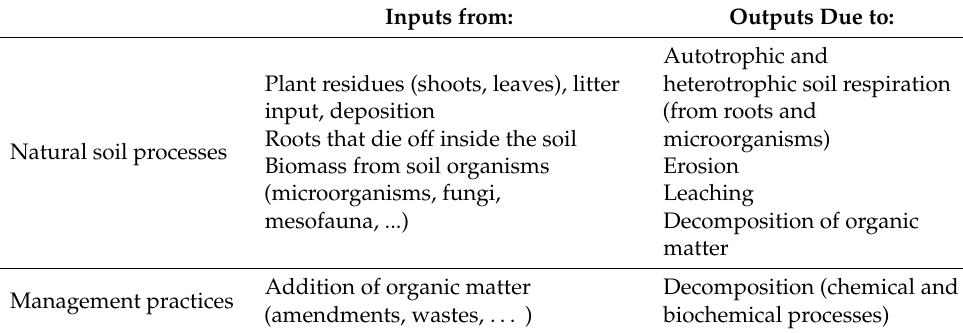
Autotrophic and heterotrophic soil respiration (from roots and microorganisms) Erosion Leaching Decomposition of organic matter Decomposition (chemical